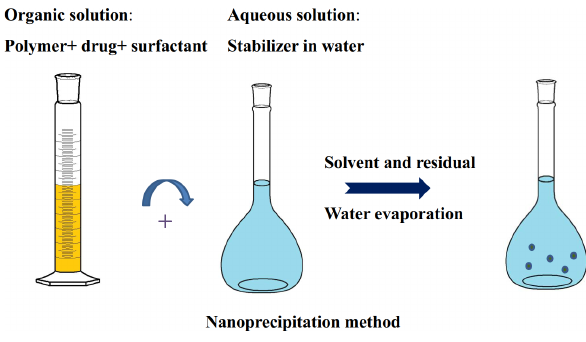
Figure 3: Schematic representation of the nanoprecipitation method for the preparation of nanoparticles